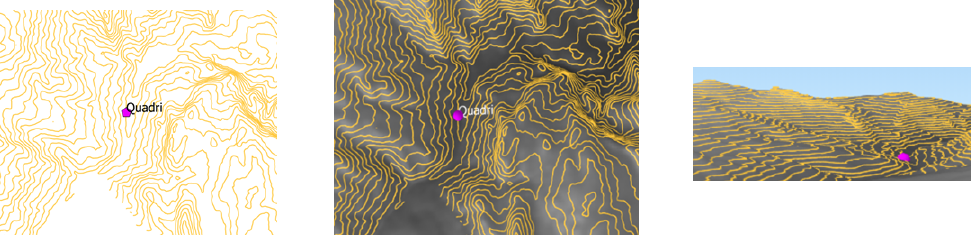
Figure 11. Three images of the terrain around the Quadri station. From left to right: a 2D map showing the contour lines near the station; an up 3D map, and a frontal 3D